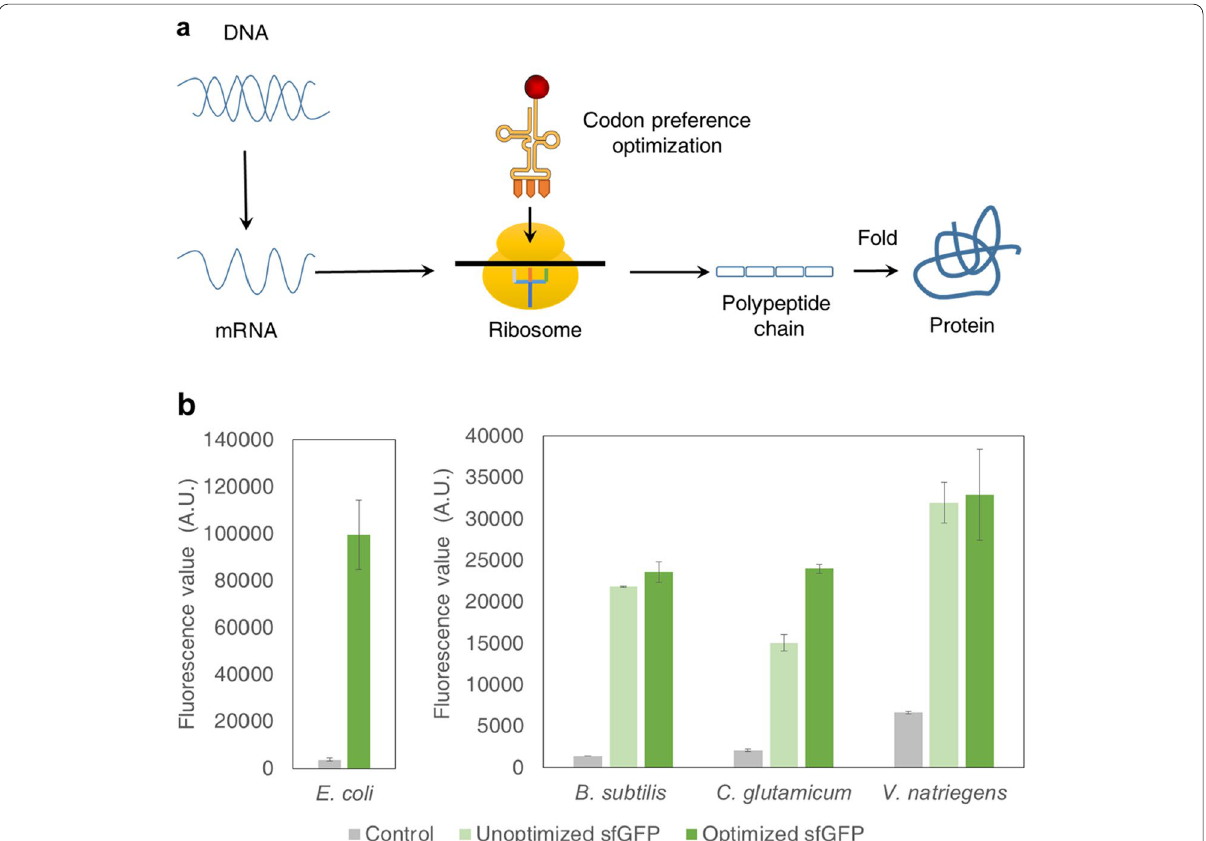
Fig. 2 Effect of codon optimization on protein expression of E. coli , B. subtilis , C. glutamicum and V. natriegens CFPS systems. a Diagram of protein expression process. b sfGFP protein synthesis level after codon optimization of E. coli , B. subtilis , C. glutamicum and V. natriegens CFPS systems. The mean and standard deviations are shown (N 3). (The control is the background value of the =